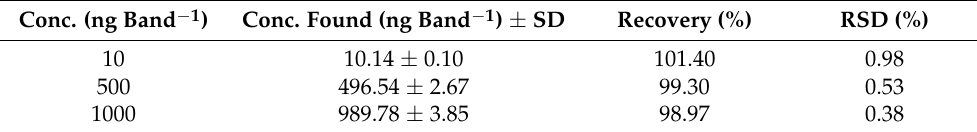
Table 2. Results of accuracy evaluation for normal-phase HPTLC technique (mean ± SD; n = 6).